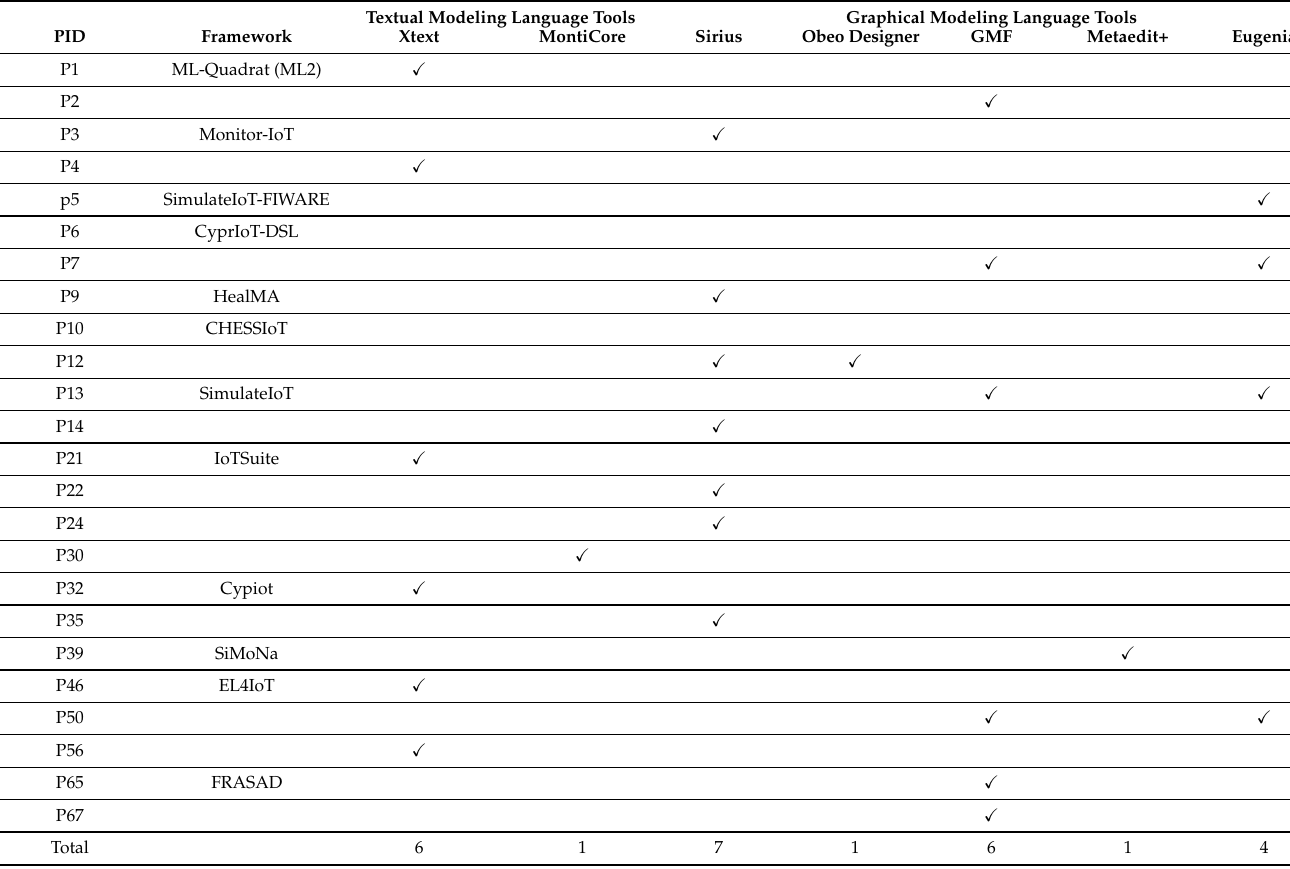
Table 3. Distribution of papers by textual and graphical modeling language